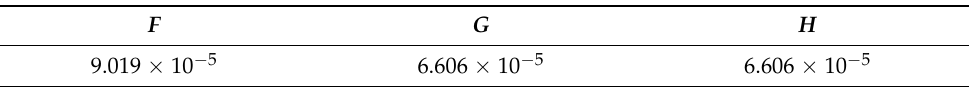
Table 3. Calculated parameters of Hill’s quadratic function for Cu-Al-Be SMA at 35 ◦ C. F G